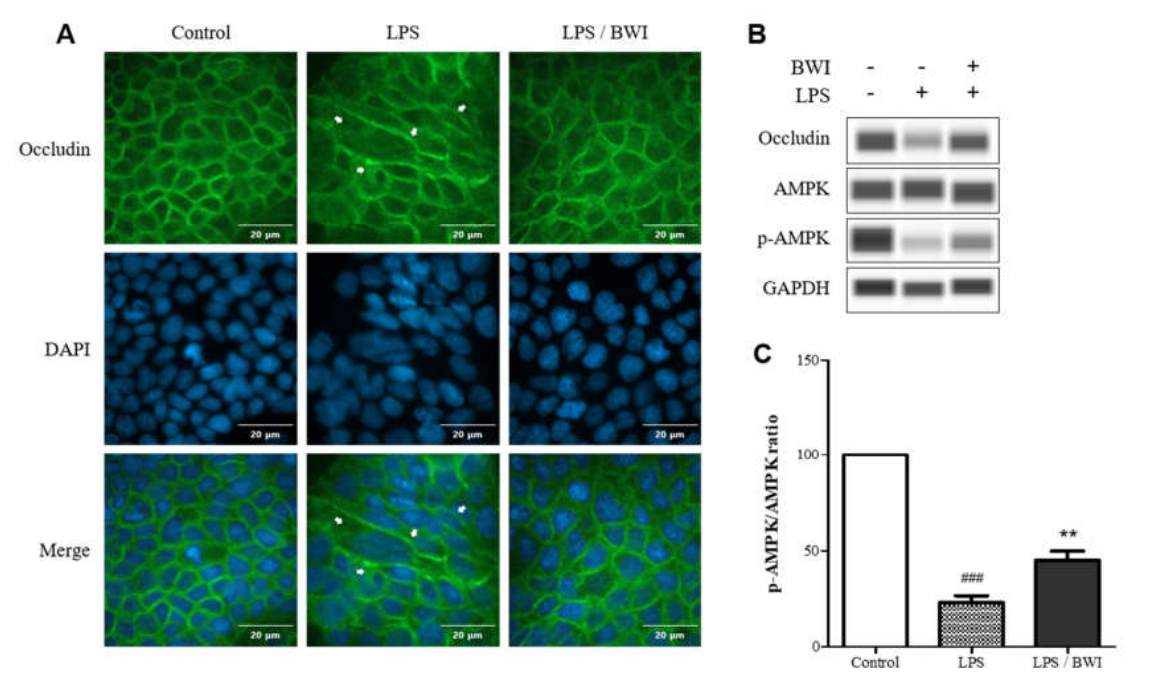
Figure 2. BWI mix mediated protection of occludin on plasma membrane and AMPK activation. ( A ) The top panel shows immunofluorescence images of occludin (green), the middle panel shows DAPI staining for nuclei (blue), and the the bottom panel shows the merged images in the presence or absence of LPS (1 ug/mL) and/or BWI mix (1 × 10 7 cells/mL) Cellular barrier damages induced by LPS are indicated by white arrows ( B ) A representative western blot analyzing relative levels of occludin, AMPK, phosphorylated (activated) AMPK, and GAPDH (loading control) ( C ) The ratios of activated ( p -AMPK) versus total AMPK in the immunoblots were quantified using Compass Simple Western software (### p < 0.001 vs. control; ** p < 0.01 vs. LPS).